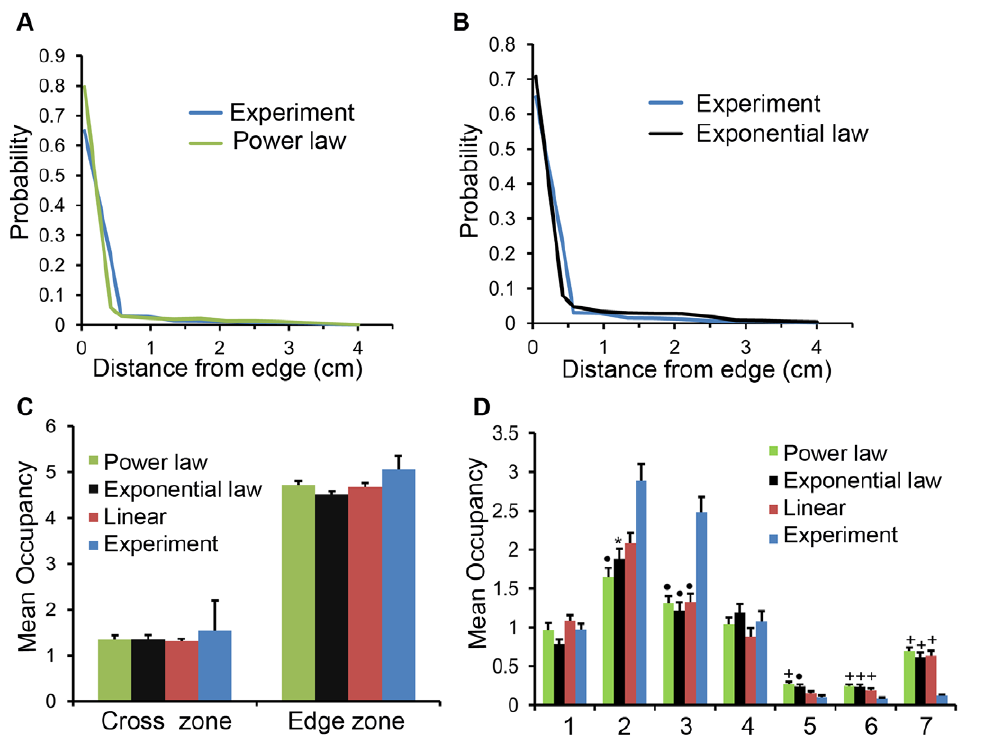
Figure 12. Positional preferences from experiments and two-component model with nonlinear wall forces in two arenas. A . Radial distribution of a wild type fly and simulations using a power law form of wall attraction, with F o ~ 0 : 0268 cm s { 1 and g ~ 3 : 357 , in the circular arena of radius 4.2 cm. Simulations using these values most closely matched the positional preference of wild type Canton-S. B . Radial distribution of a wild type fly and simulations using a exponential law form of wall attraction, with F o ~ 0 : 0268 cm s { 1 and m ~ 1 : 567 , in the circular arena of radius 4.2 cm. Simulations using these values most closely matched the positional preference of wild type Canton-S. C . We examined the preference of two spatial zones (cross and edge zones as described in Figure 3) inside 4.2 cm circular arena with internal corners. There were no statistical differences in the occupancies from simulations (both exponential and power law decay wall attraction) and experiments for the two zones. D . We examined the occupancies in seven spatial zones in the Texas area as described in Figure 8. Both the two groups of simulations using exponential and power law forms of forces captured several trends similarly to the experiments, but underemphasized the responses to the preferred areas and overemphasized the less preferred - especially zone 7. The level of significant differences between simulations and experiments are indicated using *: p v 0 : 05 , . : p v 0 : 001 , and + : p v 0 : 0001 .